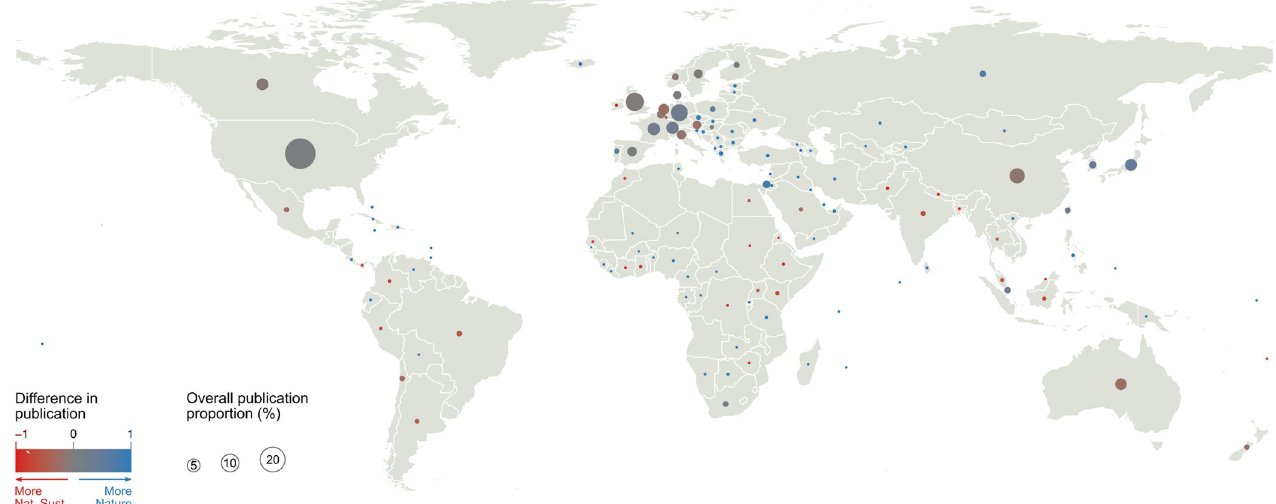
Fig 3. Difference in publication rates between Nature and Nature Sustainability . The colour scale indicates whether authors from the country publish more in Nature (blue) or Nature Sustainability (red) after accounting for total publication volume. Circle sizes reflect the country’s proportion of publication combined across both journals. When several authors from the same country co-authored the same publication, the country has been considered only once. The calculation of the difference in publication score is given in the Methods. The map was reprinted from https://www.naturalearthdata.com under a public domain license.